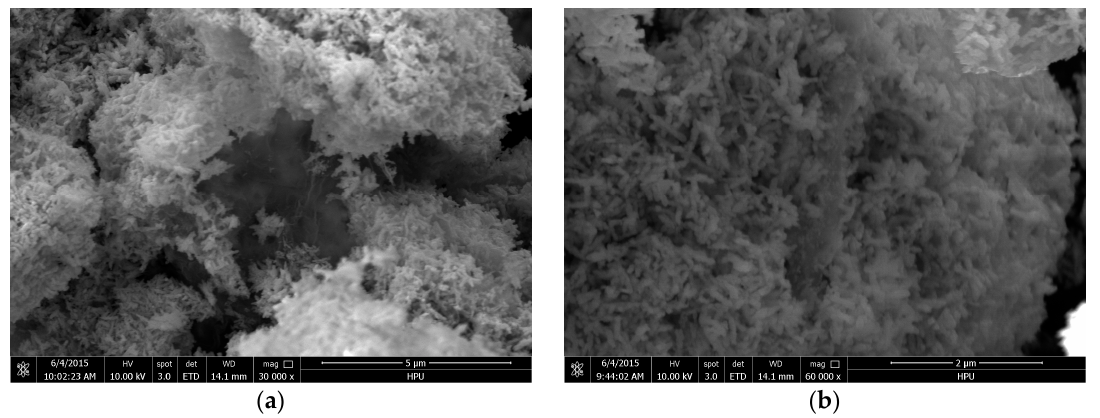
Figure 3. SEM images of the 10% ‐ RGO–CuO hybrid naocatalysts with ( a ) low magnification and ( b ) high magnification.